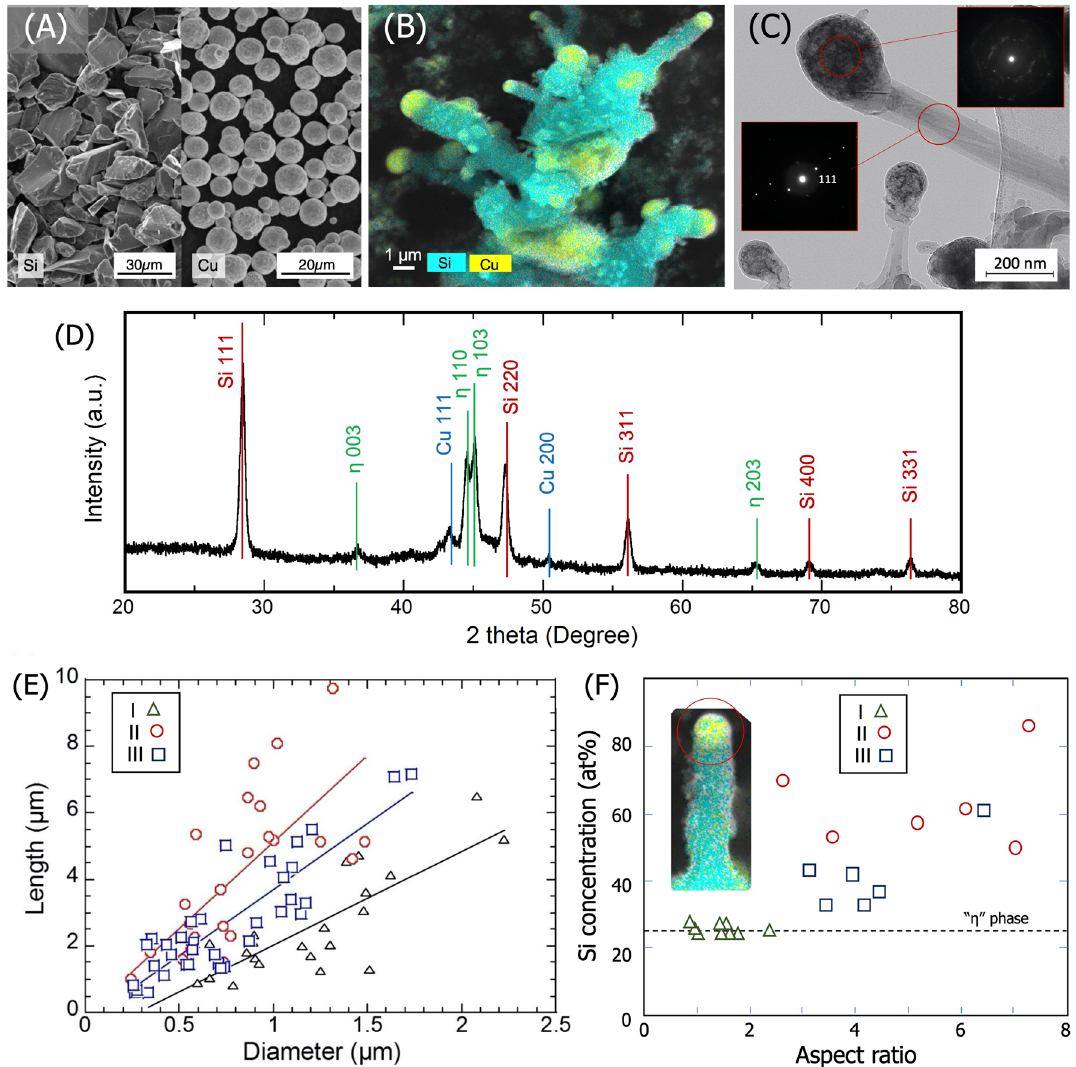
Figure 2. Scanning electron microscope (SEM) images of ( A ) Si and Cu powders, ( B ) Si nanorods (condition II) with elemental mapping analyzed by energy-dispersive X-ray spectroscopy (EDS). ( C ) High-resolution transmission electron microscopy right-field image of the Si nanorods (condition II) and electron diffraction patterns at the rod and the cap. ( D ) X-ray diffraction pattern of the nanorods (condition II). ( E ) Length and diameter of the nanorods observed in the SEM images. ( F ) Si concentrations in the hemispherical cap measured using correlation between length and diameter. The aspect ratio (AR) of the rod, represented by the slope of the linear relationship, varies from 1 under condition I to 8 under condition II. According to the definition 1 , nanomaterials produced by sPFE under the present condition is categorized as nanorod because AR is smaller than 20. The Si concentration in the Cu-rich hemispherical cap measured by SEM–EDS is also plotted in Fig. 2F as a function of the aspect ratio. For all three conditions, the minimum Si concentration in the cap is 25%; this increases slightly with aspect ratio. The Si concentration of the Cu 3 Si phase is 25% and is 32% at the eutectic point. This, therefore, confirms that the cap is composed of a mixture of Cu 3 Si and Si. Limiting step of Si nanorod growth. For VLS growth in a bottom–up approach, Si grows having the spherical Cu catalyst at the tip of the wire. During growth, while gas phase Si is supplied to one side of the cata- lytic droplet, Si is supersaturated and rejected by the droplet unidirectionally on the other side. Upon cooling, the Si-saturated catalyst droplet then solidifies to form Cu 3 Si via a eutectic reaction. The formation of Cu 3 Si at the cap of the rod is therefore the evidence of the directional growth of the rod from the Cu-rich hemispheri- cal cap. Thus, the results above confirms that VLS growth occurs in sPFE. Furthermore, Si nanorod grows in the <111> direction is (based in the EDP results) for the rods with diameter greater than 100 nm. This agrees with a previous report that the growth orientation depends on the rod diameter, whereby the <110> direction is preferred for rods smaller than 20–30 nm and the <111> direction is preferred for larger rods 16 . This further